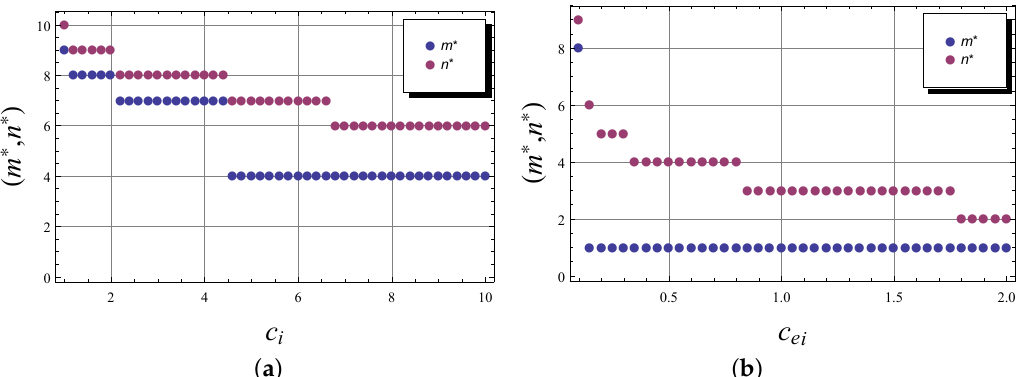
Figure 4. ( m ∗ , n ∗ ) versus c i ( a ) and c ei ( b ) for the model with an instantaneous failure.